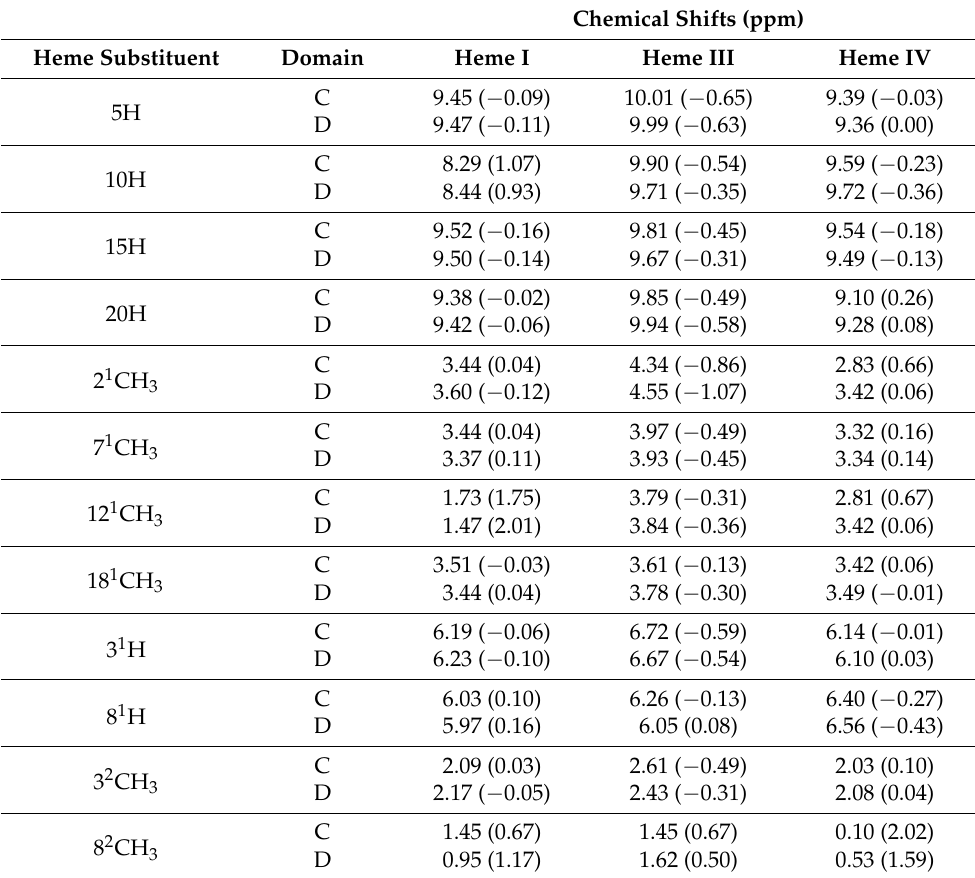
Table 2. Predicted 1 H chemical shifts and ring current shifts (in parentheses) of the heme substituents of domains C and D in the reduced state. The chemical shifts and ring current shifts were calculated from the crystal structure of bi-domain CD (PDB file